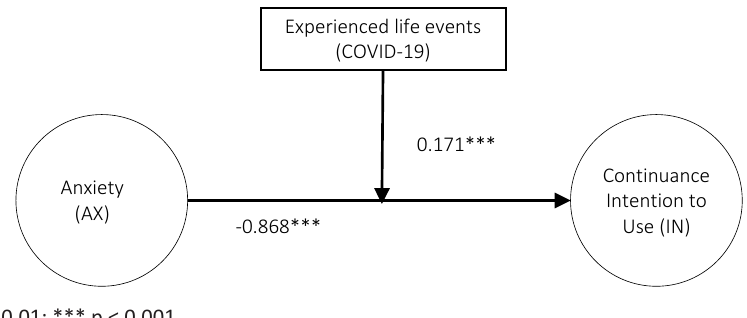
Figure 5. Influence of the moderating variable of life-experience of the COVID-19